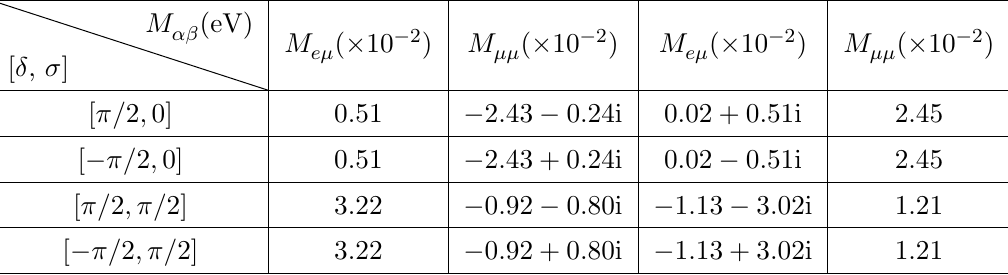
Table 4 . The possible values of M after one of them is made real by a particular value of (cid:30)